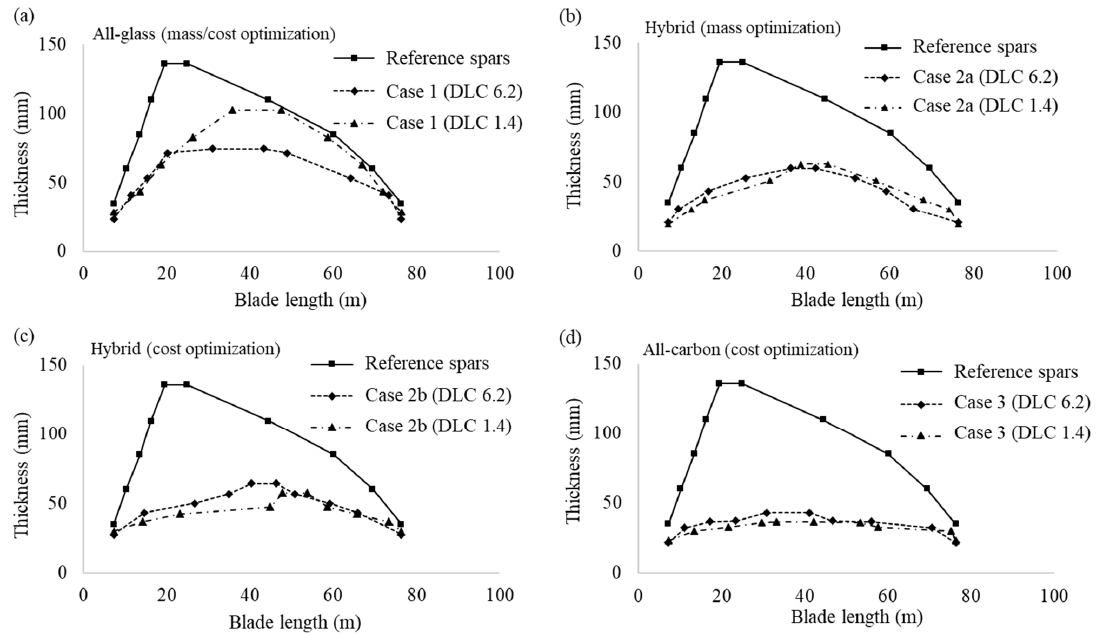
Figure 6. Thickness distributions of the optimized spars: ( a ) case 1, ( b , c ) case 2a–b and ( d ) case 3.